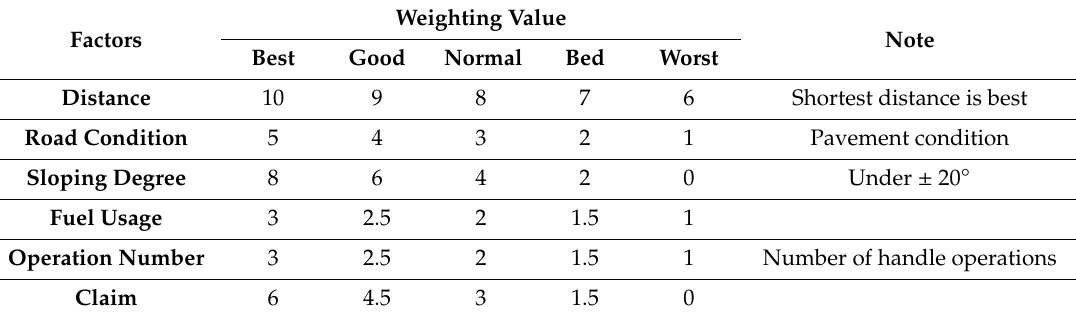
Table 3. Algorithm Weight for Optimal Path Setting.